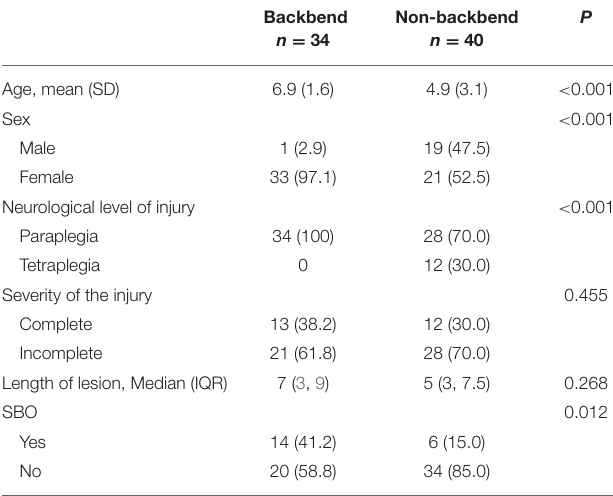
TABLE 2 | Characteristics of SCI caused by backbend and